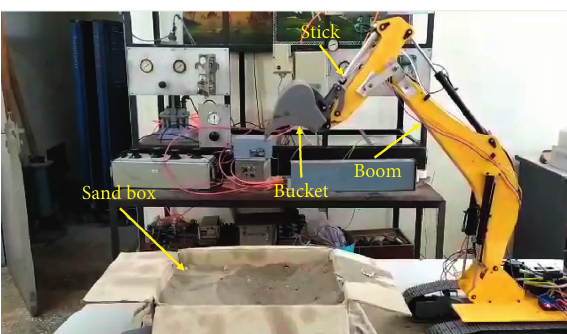
Figure 12: The laboratory size excavator. Figure 9 through 16 all indicate that the proposed algorithm has the good performances in both computer simulation and